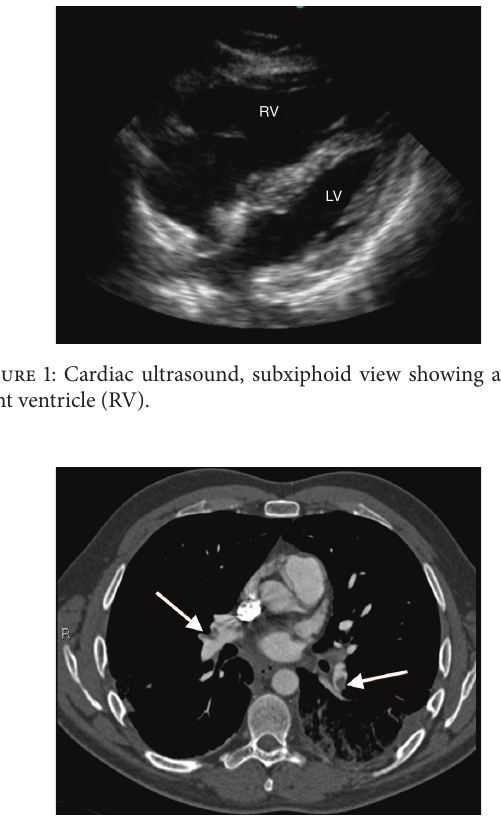
Figure 2: CT pulmonary angiography (CTPA) showinga bilateral pulmonary embolisms with clots in branch